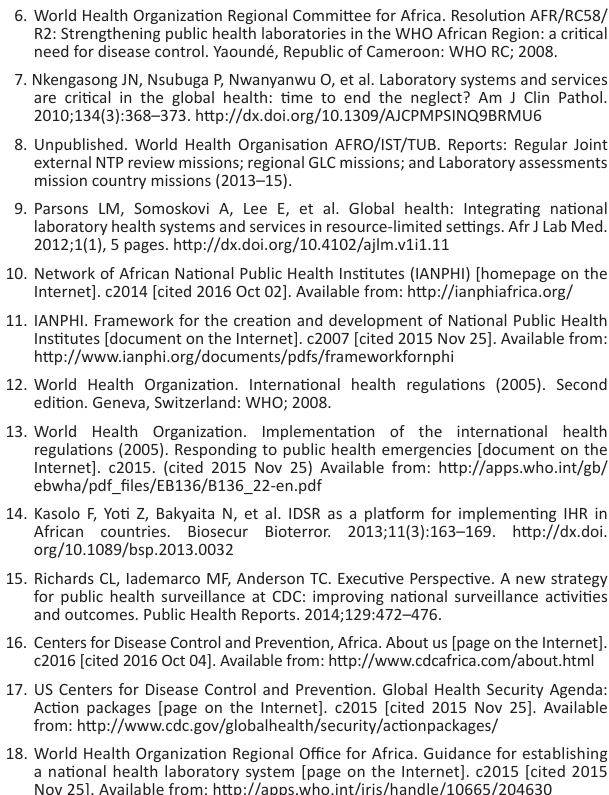
FIGURE 2: Integration as conceptual schema with three key components – laboratory networks, surveillance systems, and public health institutions. Several elements of each component are listed for integration to achieve the goal of public health laboratories. This helps with prompt adjustment to policy changes and timely detection through accurate technologies, and ensures prevent/respond measures against diseases. Achieving national and regional collaboration enhances countries’ capacities to meet the Integrated Disease Surveillance and Response and International Health Regulations